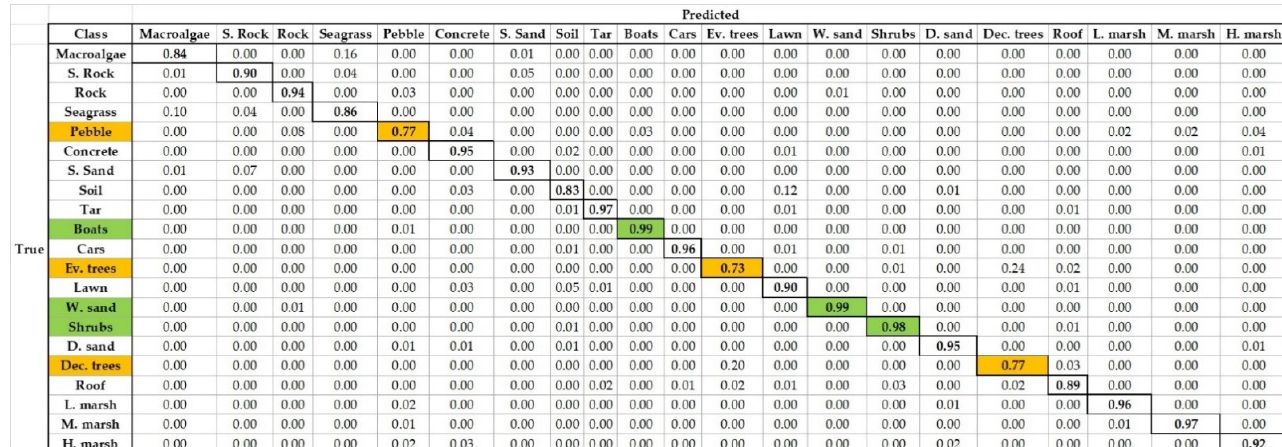
Figure 12. Seagrass meadow classification: Extract of the projected 3D map of the habitats obtained with the predictions of a random forest classifier on green spectral features, infrared intensities, and elevation values, and extract of an orthoimage of the same area. The orthoimage was captured in 2014, while lidar data are not contemporaneous as they date from 2019. S. = submerged, Ev. = evergreen, Dec. = deciduous.